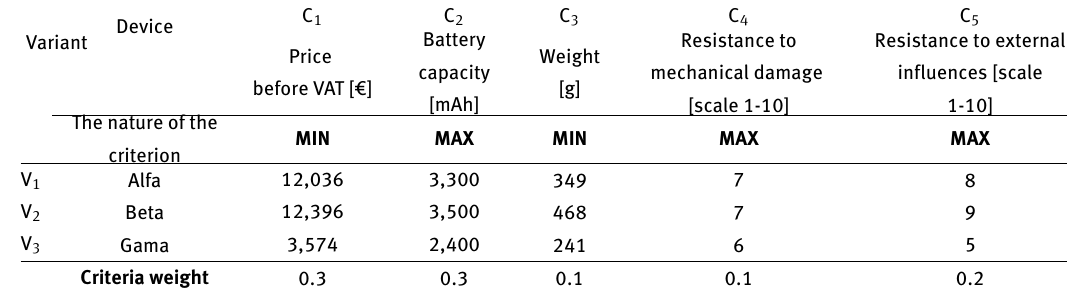
Table 5: Introductory matrix for the multi-criteria analysis